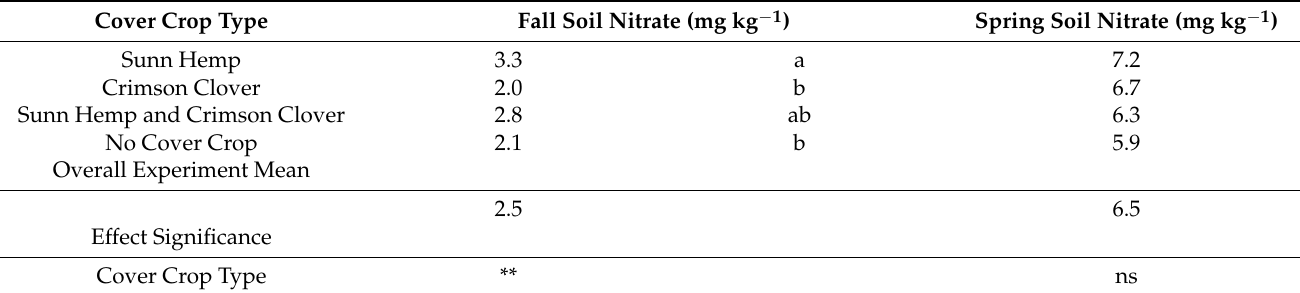
Table 3. Mean fall and spring soil nitrate following different cover crops in South Deerfield MA in 2014–2015 and 2015–2016.